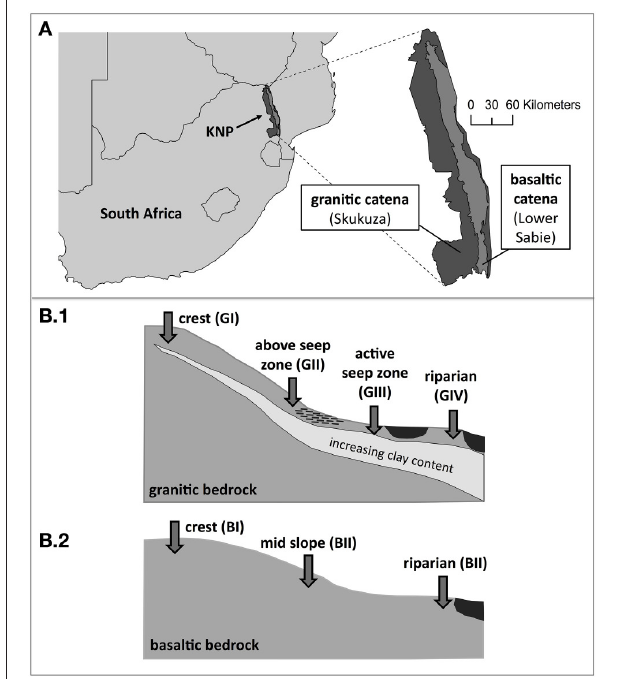
FIGURE 1 | Sampling sites. (A) Schematic map of southern Africa with Kruger National Park (KNP), a simplified overview of the park’s geology and locations of both sampled supersites near Skukuza and Lower Sabie, respectively. (B) Schematic overview of the sampling points in 5 cm depths along the two catenas on geologically different bedrock. (B1) Sampling locations at granitic catena: crest (GI), above seep zone (GII), active seep zone (GIII), riparian zone (GIV). (B2) Sampling locations at basaltic catena: crest (BI), mid slope (BII), riparian zone (BIII).